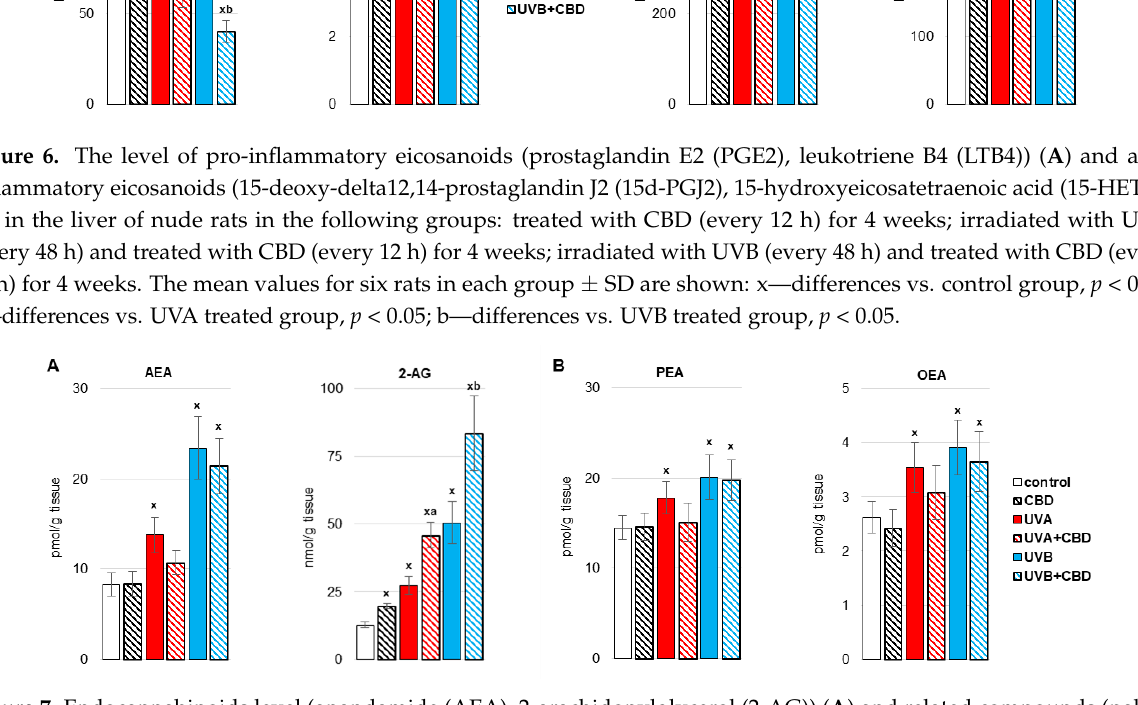
Figure 7. Endocannabinoids level (anandamide (AEA), 2-arachidonylglycerol (2-AG)) ( A ) and related compounds (pal- mitoylethanolamide (PEA), oleoylethanolamide (OEA)) ( B ) in the liver of nude rats in the following groups: treated with CBD (every 12 h) for 4 weeks; irradiated with UVA (every 48 h) and treated with CBD (every 12 h) for 4 weeks; irradiated with UVB (every 48 h) and treated with CBD (every 12 h) for 4 weeks. The mean values for six rats in each group ± SD are shown: x — differences vs. control group, p < 0.05; a — differences vs. UVA treated group, p < 0.05; b — differences vs. UVB treated group, p < 0.05.